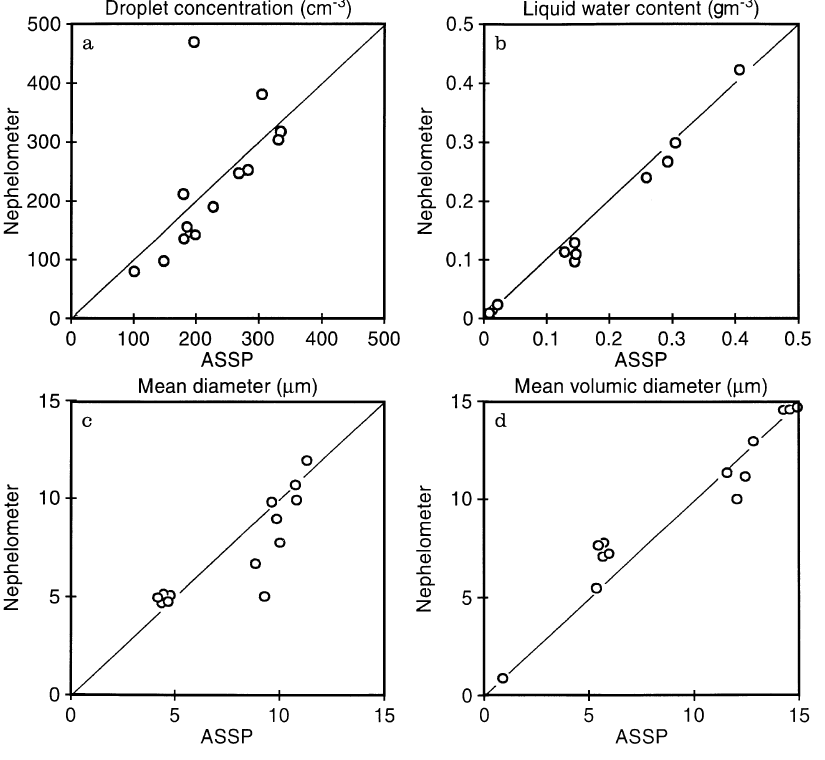
Fig. 5a–d. Retrieved microphysical parame- ters versus the direct ASSP parameters ob- tained for di(cid:128)erent cloudy conditions characterized by only cloud water droplets. a cloud droplet concentration, b Liquid water content; c mean diameter and d mean